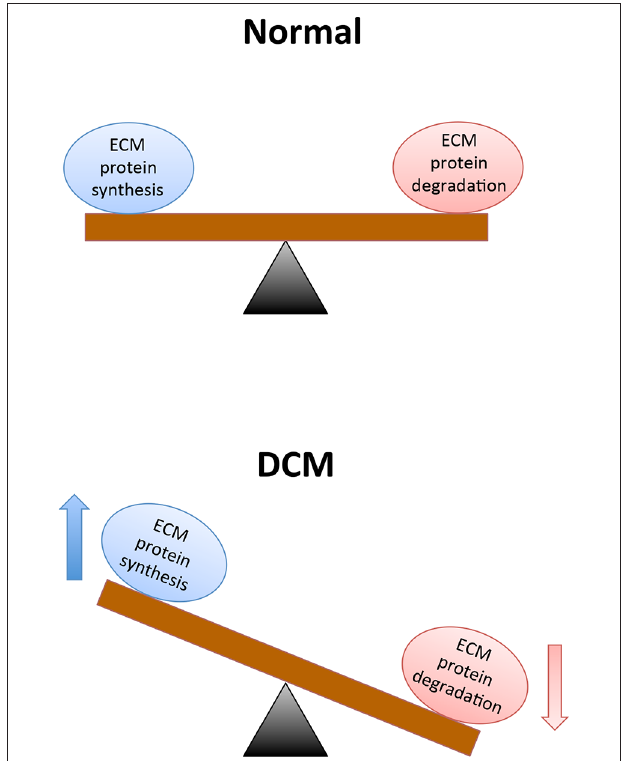
FiGuRe 1 | A chronic hyperglycemic environment causes excessive extracellular matrix protein deposition, which subsequently contributes to cardiac fibrosis and cardiac dysfunction. Legend: ECM = Extracellular matrix, and DCM = Diabetic